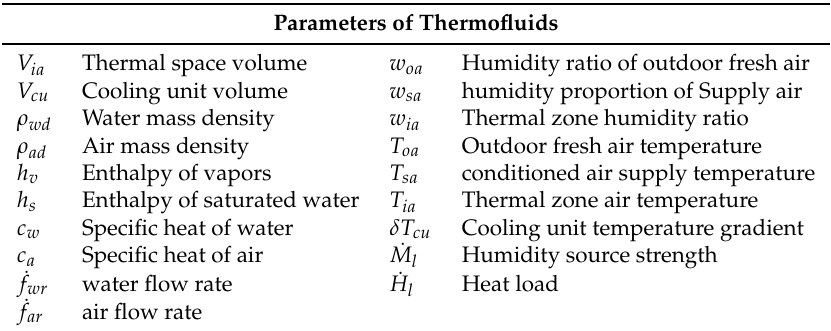
Table 1. Air handling unit thermo-fluid